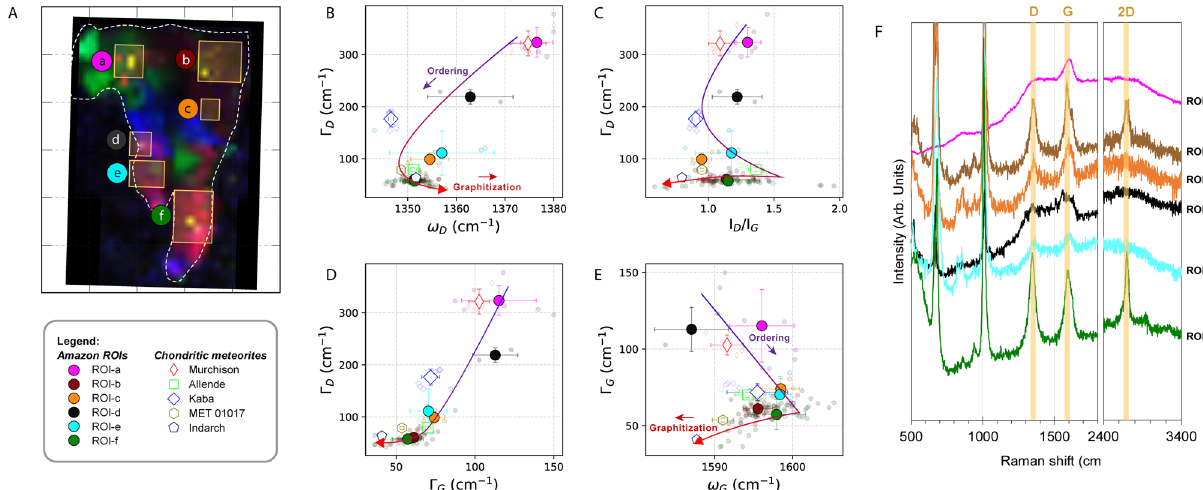
Figure 2. Organic composition of Amazon. ( A ) Six ROIs (a: disordered organics; b–f: heated organics) are marked by the yellow boxes. ( B – E ) Comparison of the Raman D and G band parameters (ω = peak center locations, Γ = full-width half-maximum, I D /I G = peak intensity ratios between the D and G bands) of the organic material in Amazon and chondritic meteorites. The values were obtained by peak fitting to the two-peak Lorentzian model and linear baseline correction to allow comparison to literature data. Data of MET 01017 and Indarch are from 29 . Uncertainties are 1σ SD of the mean. ( F ) Selected Raman spectra of each ROI showing the first-order D and G bands, and the second-order 2D